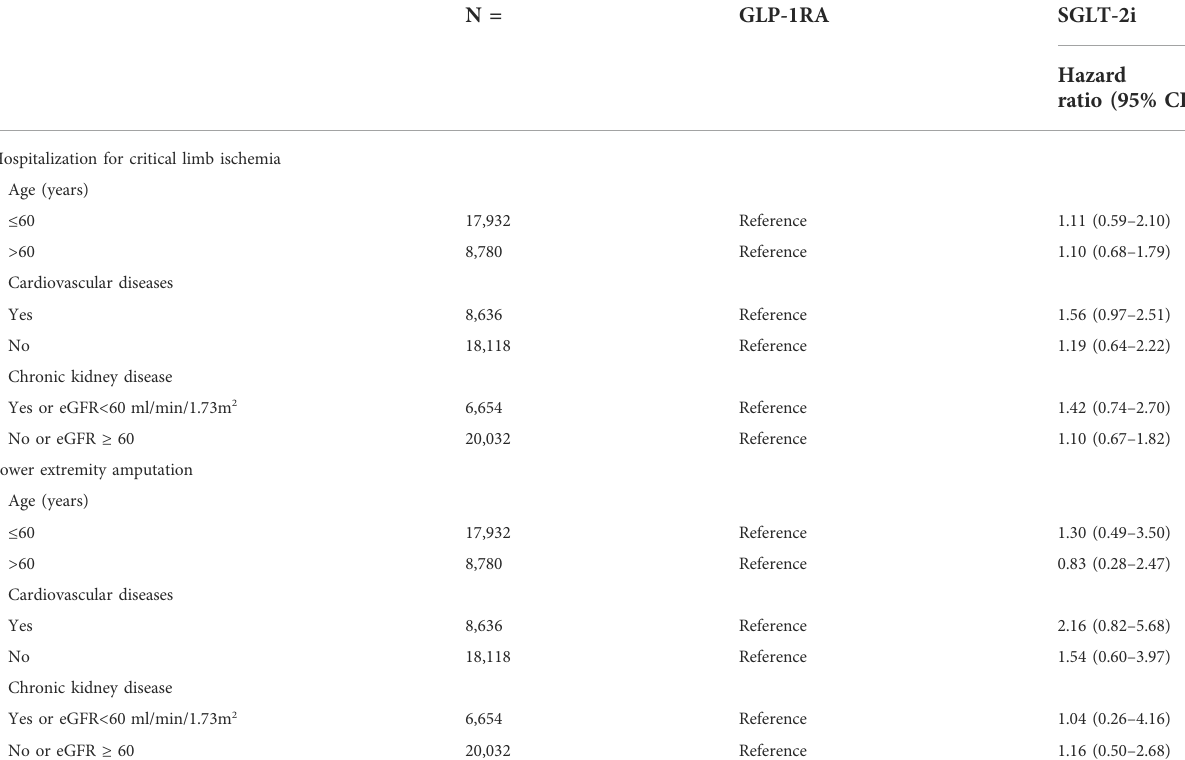
TABLE3Subgroupanalyses:hazardratiosofhospitalizationforcriticallimbischemiaandlowerextrimityamputationstrati fi edbyage,cardiovascular disease and chronic kidney